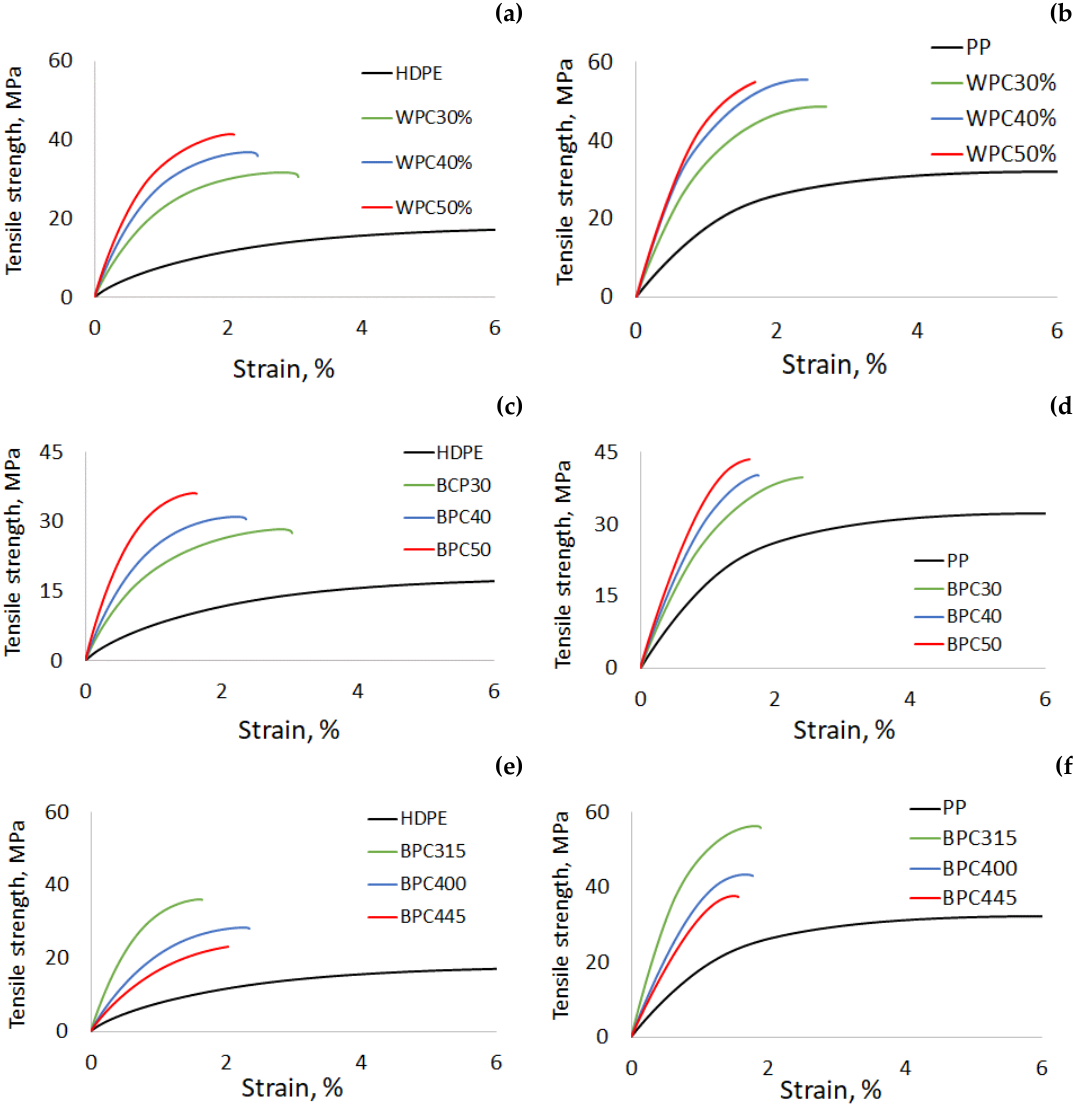
Figure 4. Typical tensile strain ‐ stress curves of wood polymer (WPC) and biochar polymer (BCP) composites: i) Effect of fiber proportion on ( a ) HPPE and ( b ) PP WPCs, and ( c ) HDPE and ( d ) PP BCPs; and ii) effect of pyro ‐ gasification temperature on ( e ) HDPE and ( f ) PP BPCs.